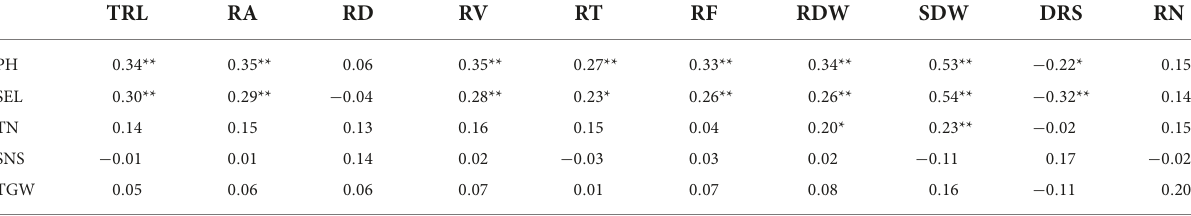
TRL total root length, RA root area, RV root volume, RD root diameter, RT root tips, RF root forks, RDW root dry weight, SDW shoot dry weight, DRS dry root–shoot ratio, RN root number, PH plantheight, SEL spikeextensionlength, TN tillernumber, SNS spikeletnumberperspike, TGW thousand-grainweight.*and**meansignificantdifferenceat P < 0.05and